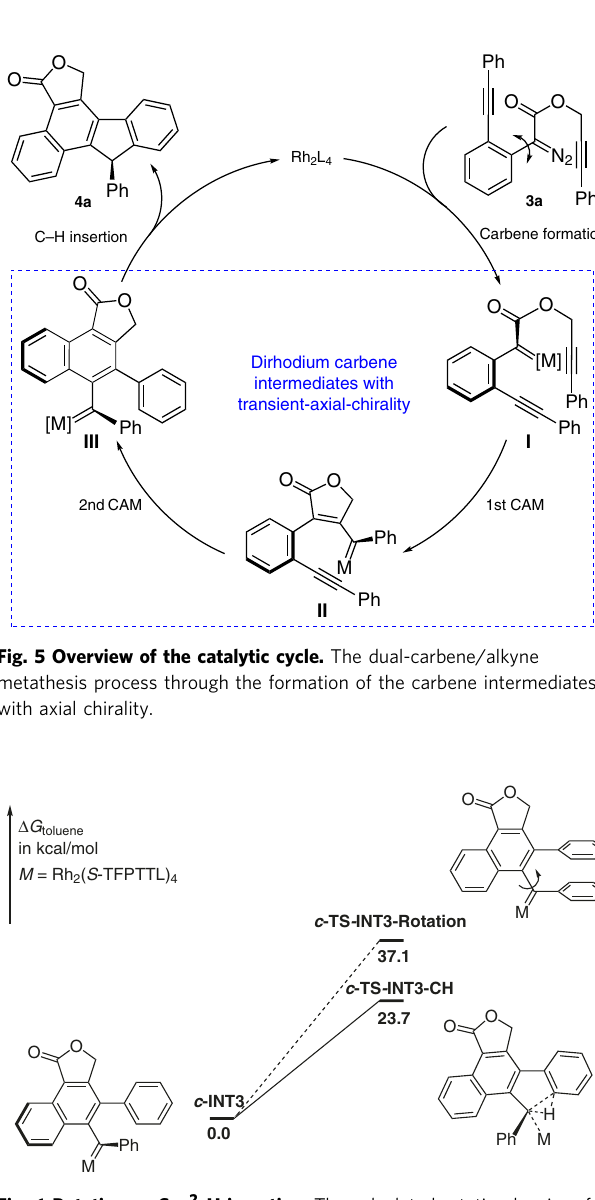
Fig. 6 Rotation vs Csp 2 – H insertion. The calculated rotation barrier of c - INT3 is 13.4 kcal/mol higher than C – H insertion